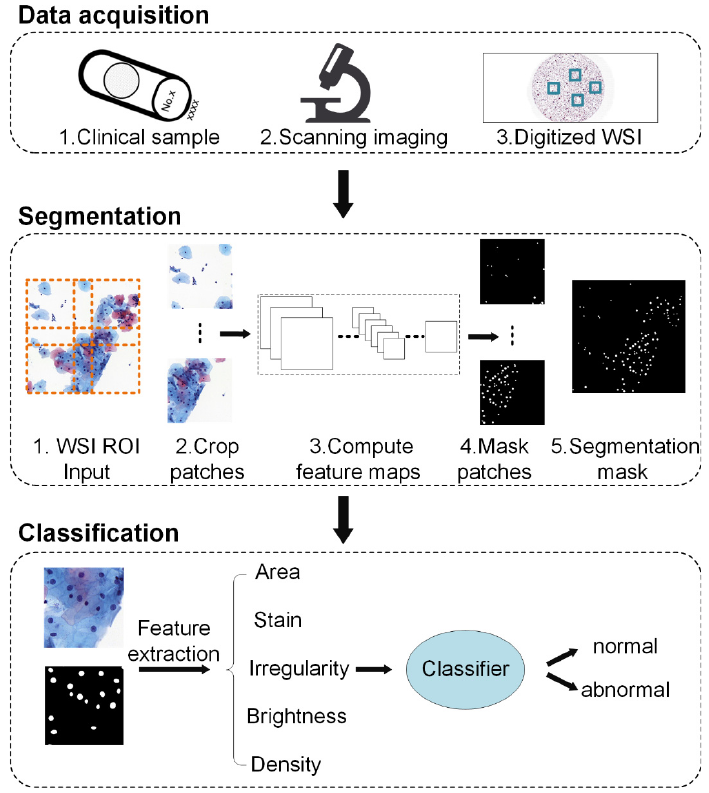
Fig. 1. The overview for the proposed work. Segmentation: we crop the data into patches which match up with the size of Mask- RCNN's input in an overlapping crop. Hence, there exists overlapping region between the neighboring mask patches output by the